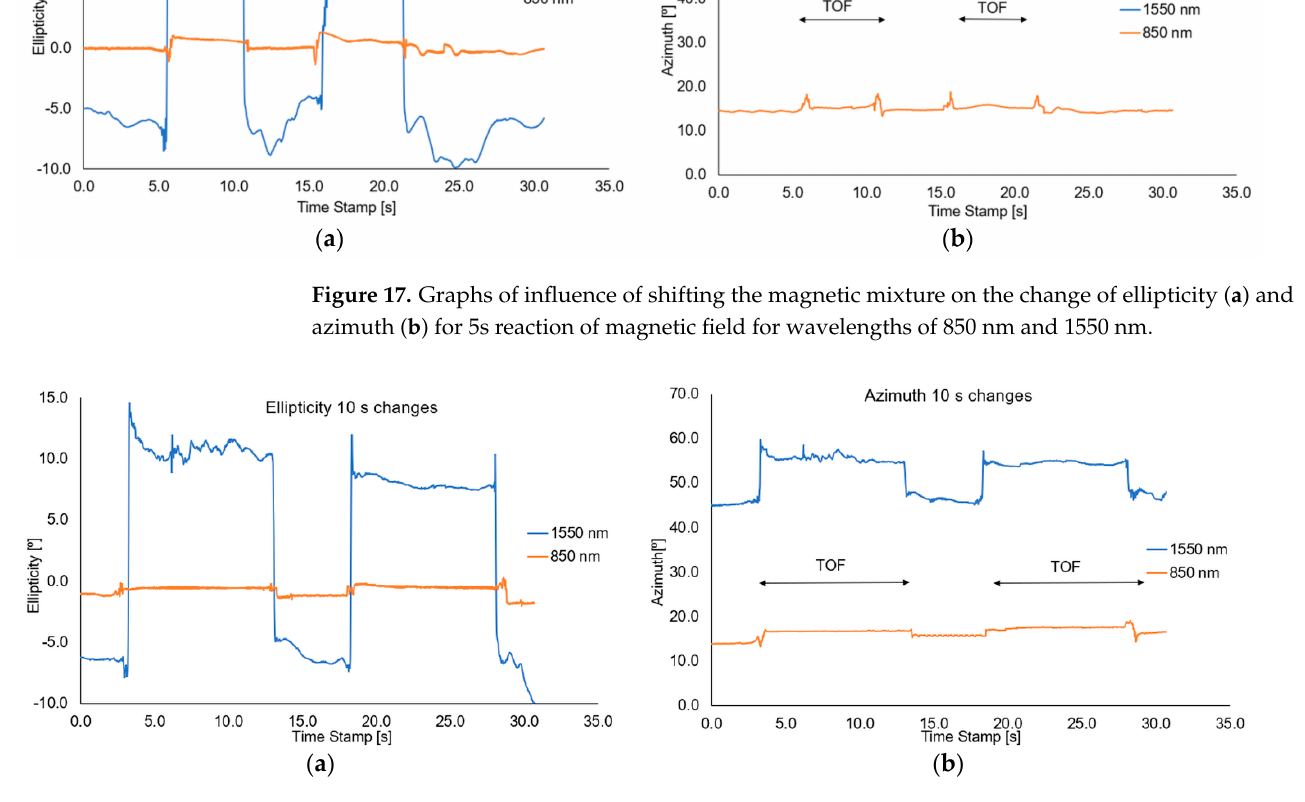
Figure 18. Graphs of influence of shifting the magnetic mixture on the change of ellipticity ( a ) and azimuth ( b ) for 10 s reaction of magnetic field for wavelengths of 850 nm and 1550 nm.